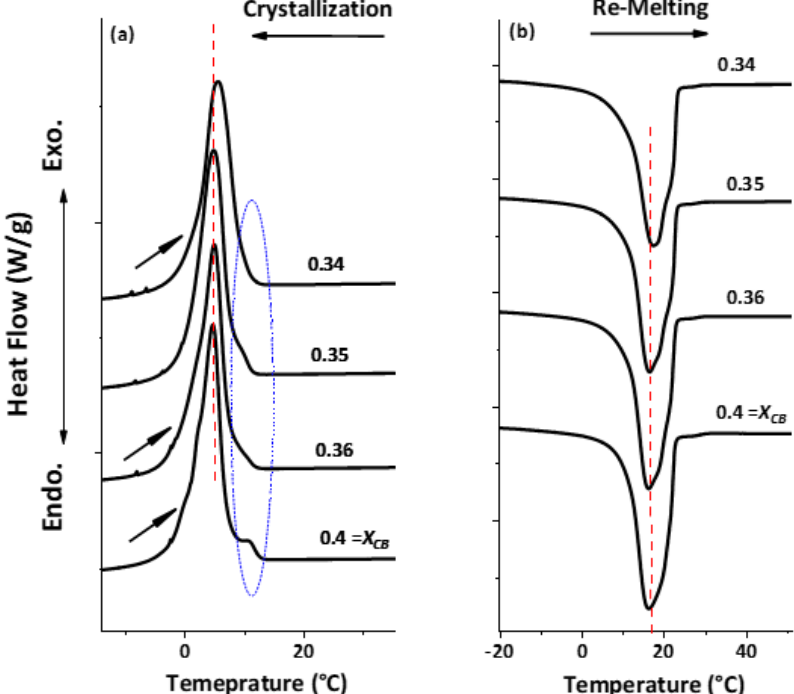
Figure 5. DSC analysis of CB / CO blends for the determination of eutectic mixture. The samples were prepared similarly like other blends and the same process was used for DSC measurements. ( a ) Dynamic crystallization from 90 °C to −50 °C. ( b ) Remelting of crystals formed in segment ( a ).